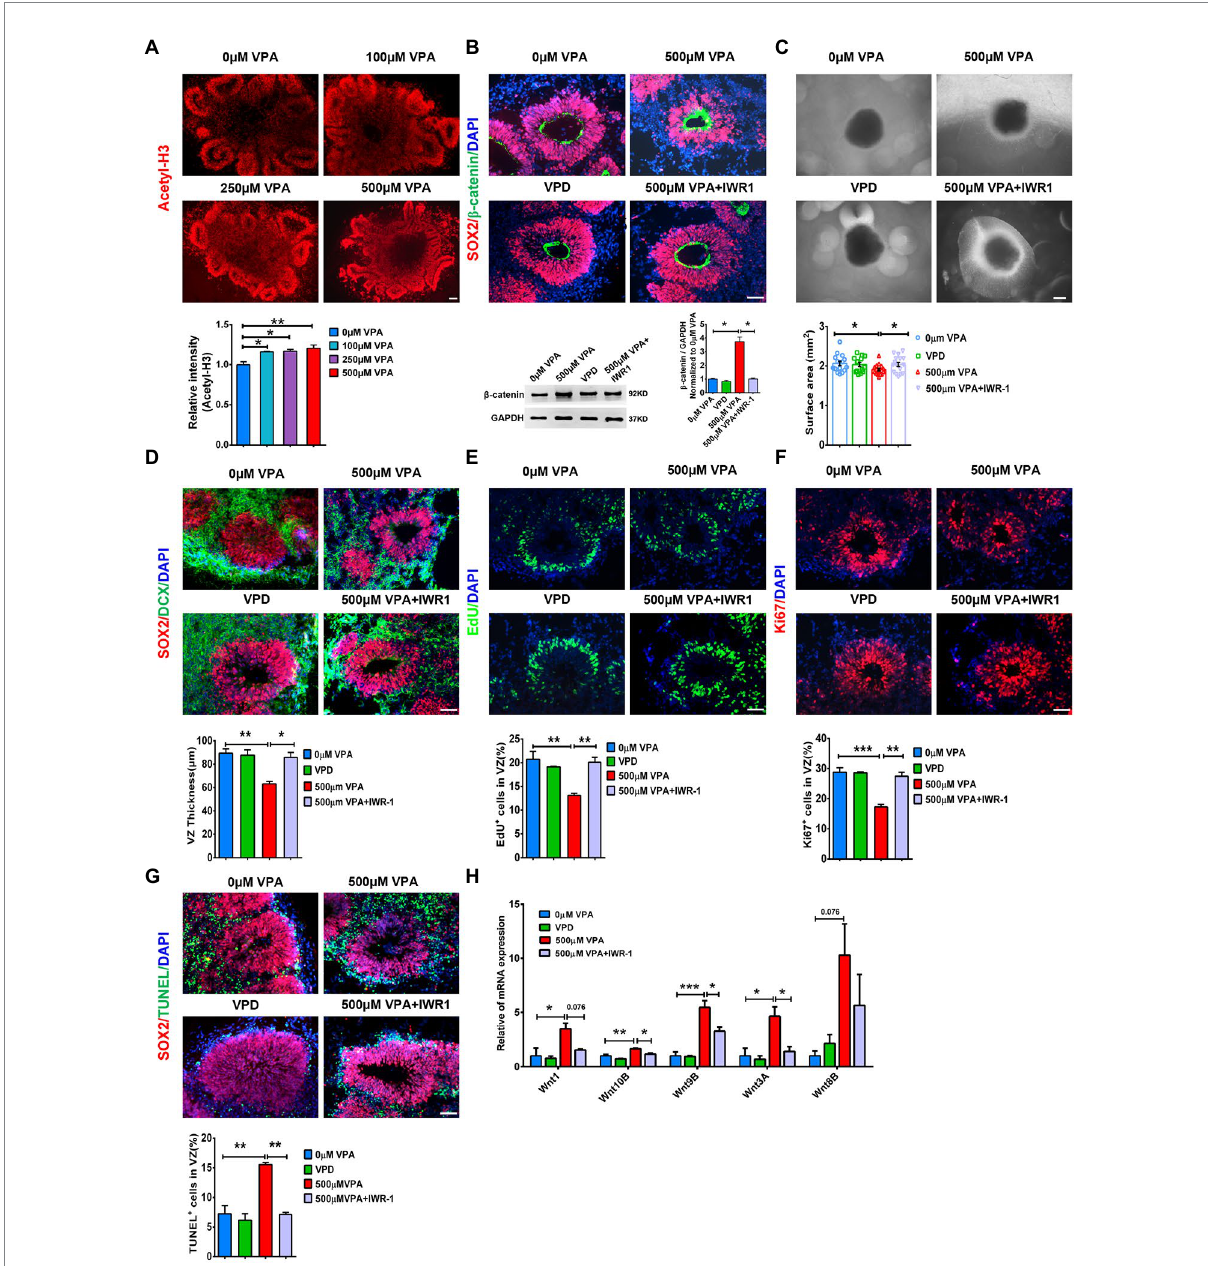
FIGURE 8 Wnt/ β -catenin inhibition rescued deficits in neurogenesis in VPA treated organoids. (A) Representative image of 0, 100, 250, and 500 μ M VPA treated human dorsal forebrain organoids and quantification of acetyl-H3 staining at day 28 ( n = 3 organoids each). Scale bar, 100 μ m. (B) Representative images of SOX2 (red) and β -catenin (green) staining in the cerebral organoids and quantification of β -catenin protein using western blotting at day 28 ( n = 3 organoids each). Scale bar, 50 μ m. (C) Representative images of organoids with 0 μ M VPA, 500 μ M VPA, 1 mM VPD, and 500 μ M VPA + 10 μ M IWR-1 treatment and quantification of surface areas of the cerebral organoids at day 28 (0 μ M, 500 μ M VPA, 500 μ M VPA + 10 μ M IWR-1: n = 16 organoids, 1 mM VPD: n = 14 organoids). Scale bar, 500 μ m. (D) Representative images of SOX2 (red) and DCX (green) and quantification of VZ thickness ( n = 3 organoids each). Scale bar, 50 μ m. (E,F) Immunostaining for EdU and ki67 and quantification of the percentage of EdU + (E) and Ki67 + cells (F) in VZ-like regions ( n = 3 organoids each). Scale bar, 50 μ m. (G) Immunostaining for SOX2 (red) and TUNEL (green) and quantification of the percentage of TUNEL + cells in VZ-like regions ( n = 3 organoids each). Scale bar, 50 μ m. (H) The expression levels of five Wnt genes were quantified by RT-qPCR ( n = 3 organoids each). * p > 0.05, ** p > 0.01, *** p >